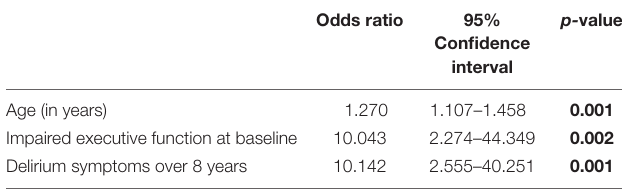
TABLE 4 | Multivariate analysis of risk factors associated with occurrence of